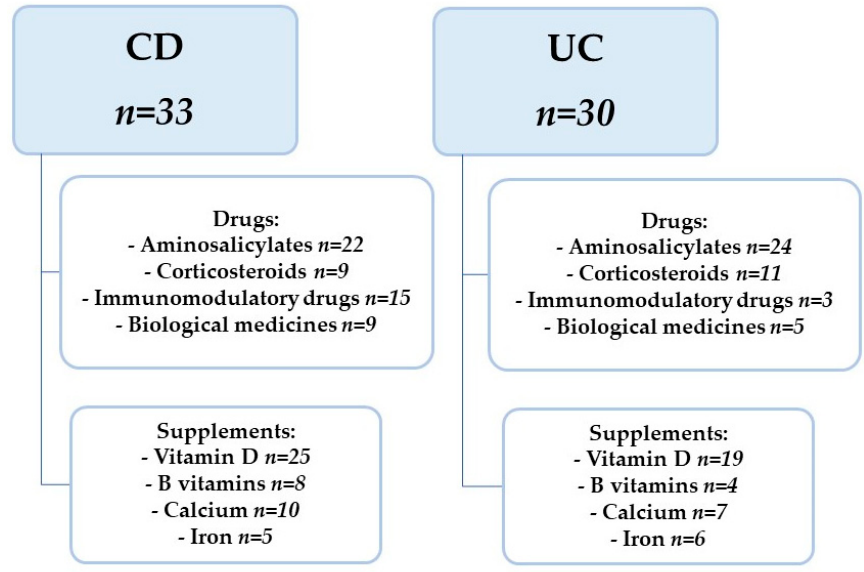
Figure 1. Characteristics of drugs and dietary supplements used. CD — Crohn’s Disease, UC — Ulcerative Colitis.